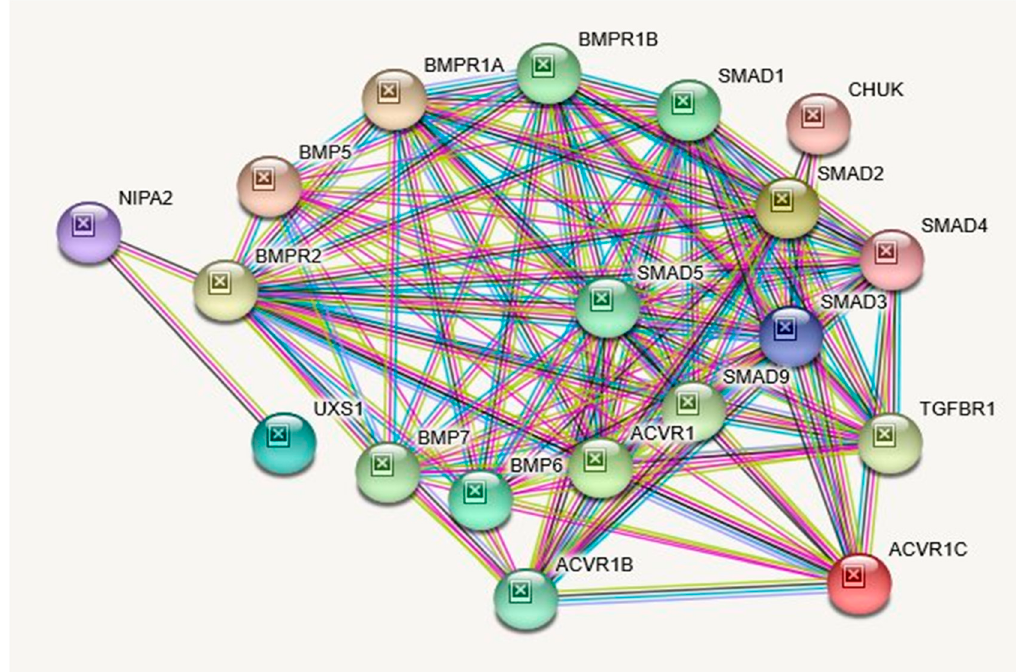
Figure 4. STRING Protein–Protein Interaction Network for NIPA2 gene with functional interactions with 17 nodes. (Source: STRING.org). Network nodes represent proteins with splice isoforms or post-translational modifications collapsed into each node for all proteins produced by a single protein-coding gene. Edges represent protein-protein associations that are considered specific and meaningful (i.e., proteins jointly contribute to a shared function, such as, Biological Process (GO) and Molecular Function (GO) (Table 6). NIPA2 gene protein Interactants and their functions are listed in Table 8. (See Figure 2 for legend with a description of symbols and notes on interpreting the interaction of genes and their encoded proteins). STRING Protein Interactants and Their Functions for NIPA2 gene are listed in Table 8.